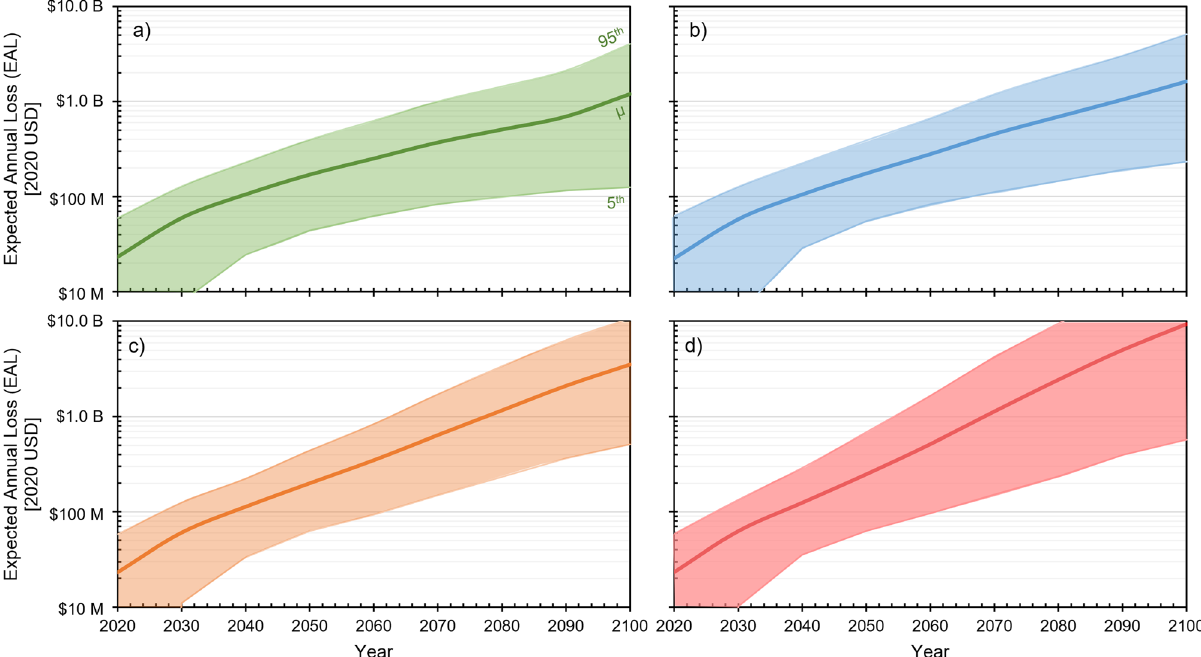
Fig. 5 MBTA rail rapid transit system Expected Annual Losses (EAL) associated with coastal fl ood risk over time under several uncertain IPCC 6 th Assessment Report (AR6) sea level rise (SLR) projections. Expected values (thick line) and 90% con fi dence interval (shaded regions) for uncertain EAL over time, given uncertain future SLR projections under the: a SSP1-2.6 projection (green), b SSP2-4.5 projection (blue), c SSP5-8.5 (orange), d SSP5-8.5 projection inclusive of low con fi dence processes (red).